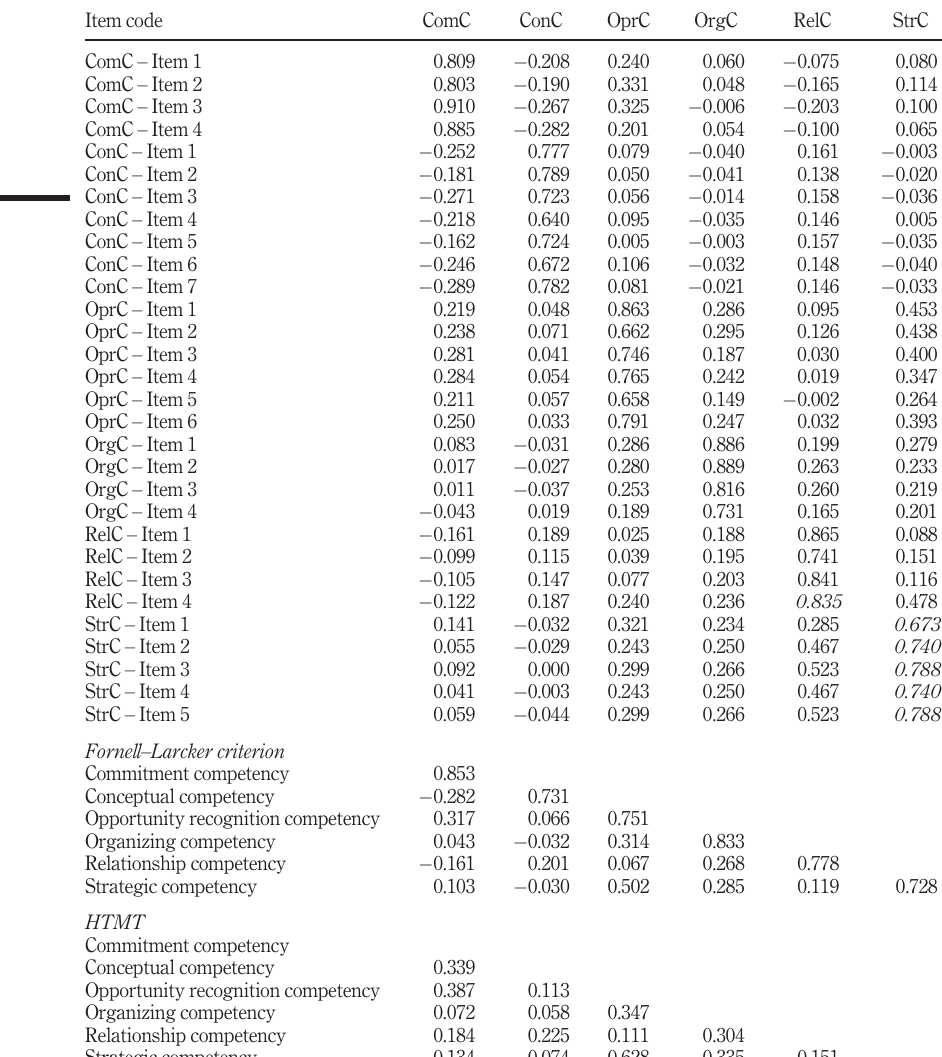
Table III. Loadings and